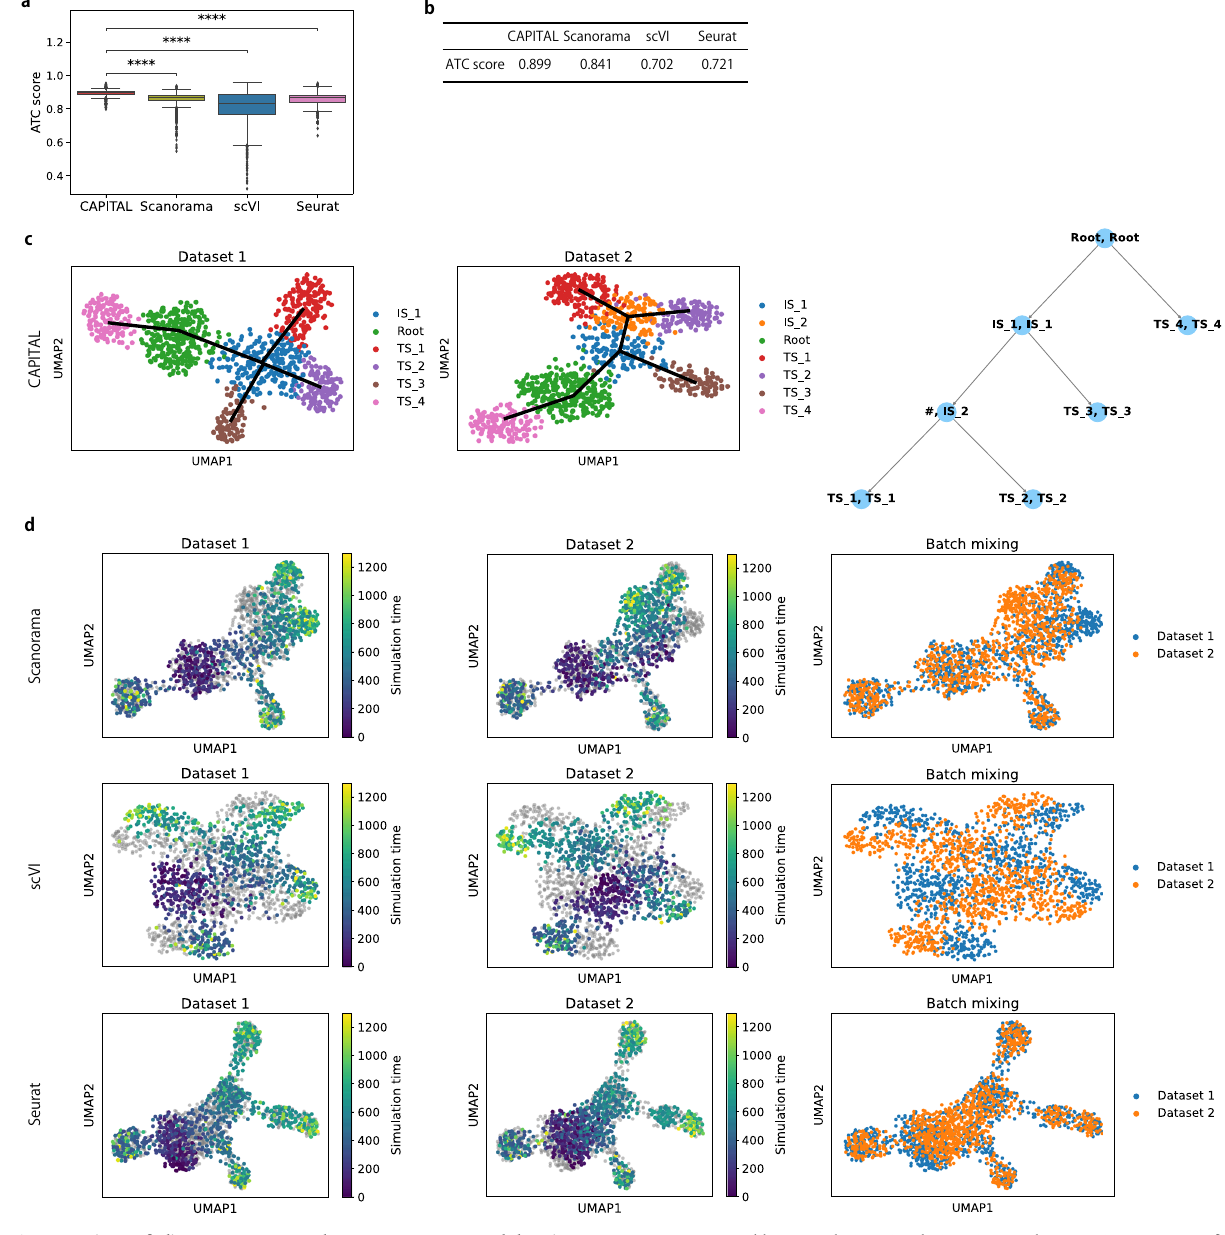
Fig. 4 | Comparison of alignment accuracy between CAPITAL and data inte- gration methods on a pair of synthetic datasets. a Performance evaluation in trajectory conservation at the single-cell level on 2278 pairs of the synthetic data- sets. A one-sided Wilcoxon singed-rank test was performed for each pair of the methods. ****indicates a p -value<1.00×10 − 226 (3.18×10 − 272 , 7.32×10 − 239 , and 7.76×10 − 227 for CAPTAL vs. Scanorama, CAPITAL vs. scVI, and CAPITAL vs. Seurat, respectively),meaningthattheATCscoreofCAPITALwassigni fi cantlyhigherthan those of the other tools. The box plots show the median with bounds for the fi rst and the third quartiles, and the whiskers indicate the minimum and the maximum that exclude outliers represented by points. b ATC scores of all tools on datasets 1 and 2. c UMAP plots of datasets 1 and 2 with Leiden clustering, whose cell types